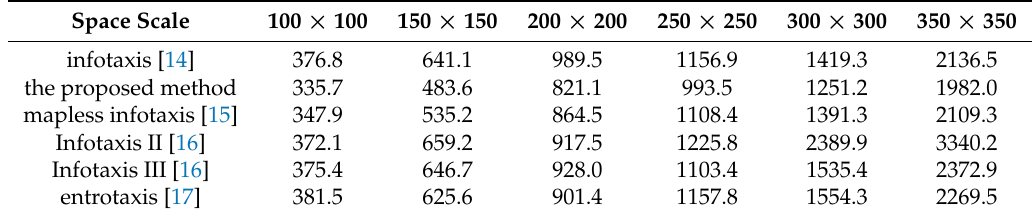
Table 1. Mean search time (steps) for the infotaxis methods with varying scale of the search